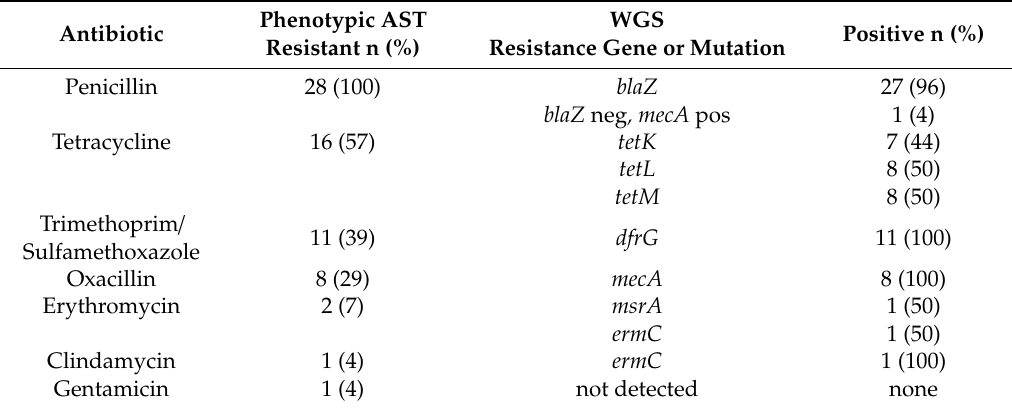
Table 2. Phenotypic antibiotic resistance and associated genetic resistance